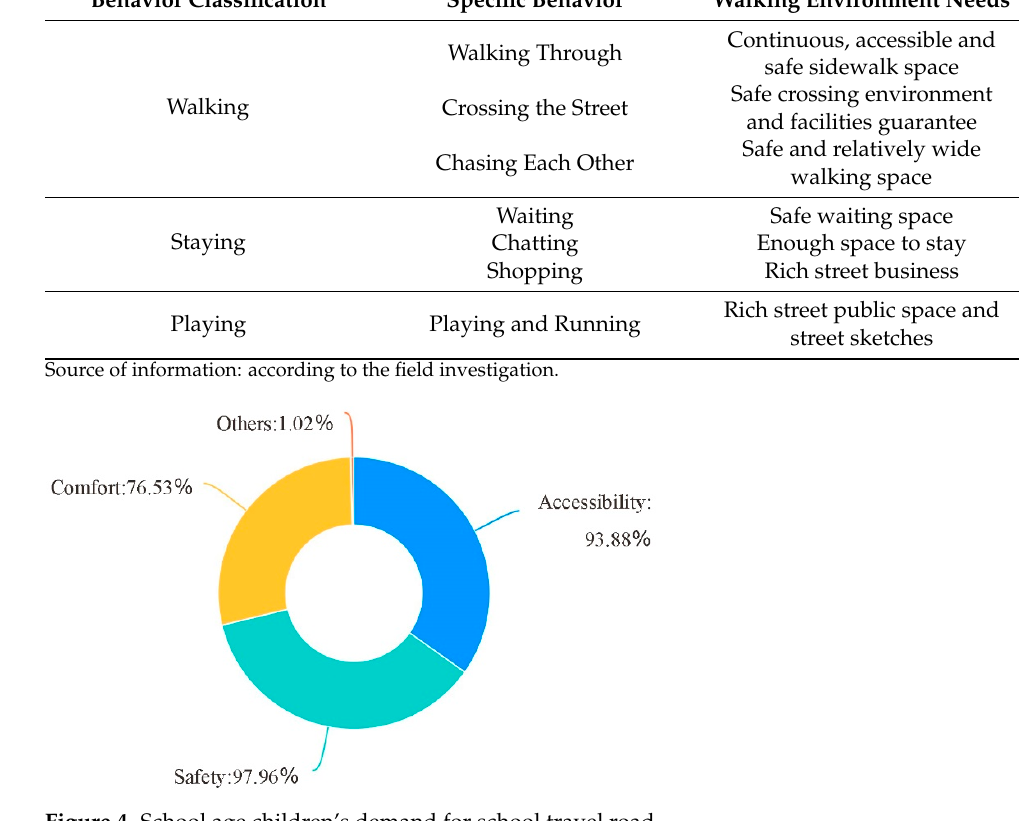
Figure 4. School age children’s demand for school travel